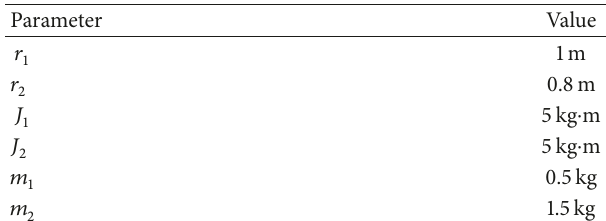
Table 1: Parameters of the two-link robotic manipulator.